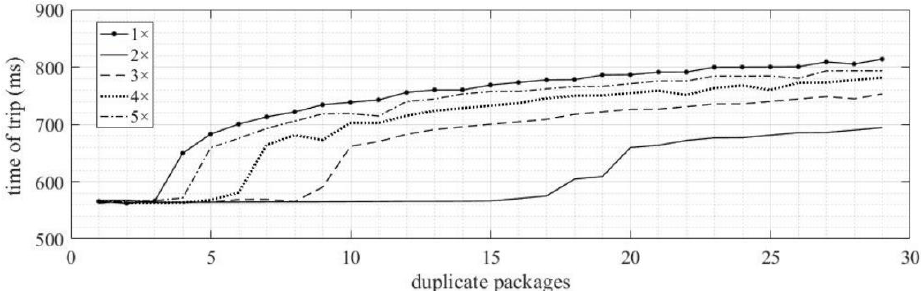
Figure 19. Tripping time results ANSI 51 — duplicate of SV